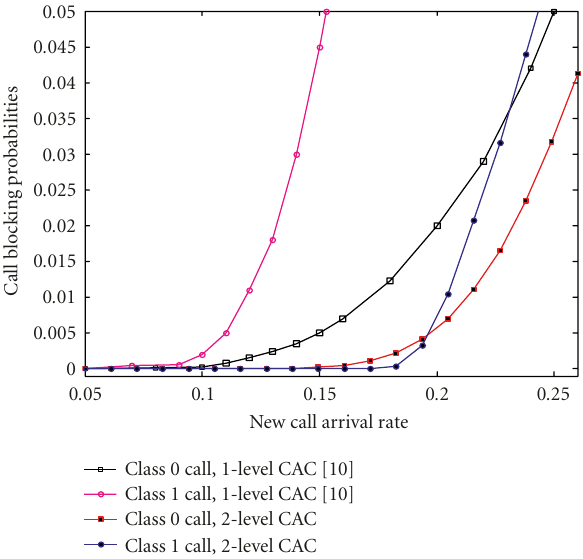
Figure 3: Class 1 call blocking probabilities versus W d /W ( Λ = 0 . 1, W res /W = 0 . 1) .